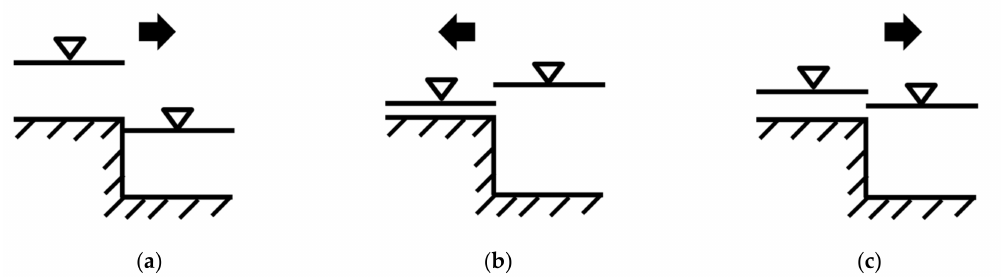
Figure 2. Schematic diagrams denoting the flow reflux between adjacent grids; ( a ) 1st time step; ( b ) 2st time step; ( c ) 3st time